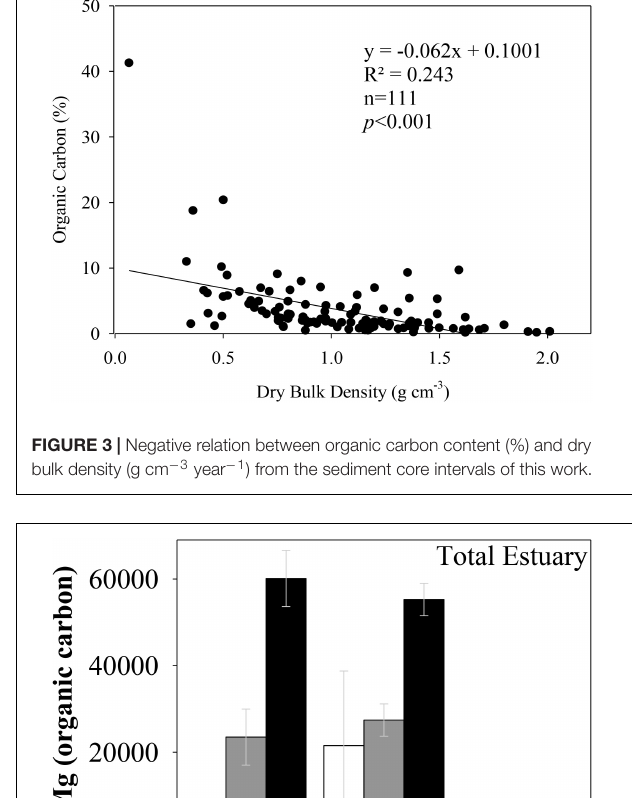
TABLE 3 | Estimates of components of variation from PERMANOVA.